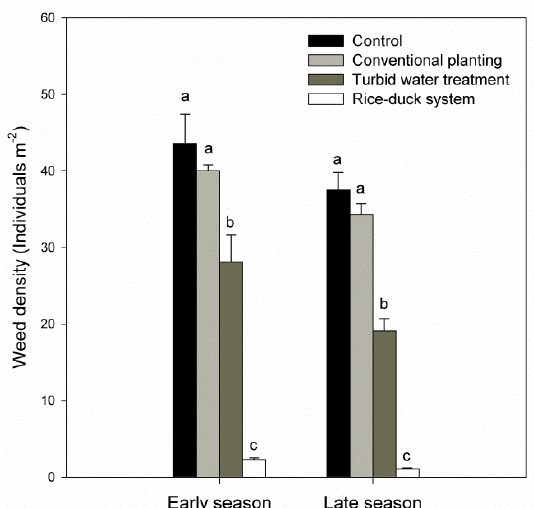
Figure 5. Weed density in the early and late seasons of rice growth under the treatments and control. Bars present the mean and error bars present the standard error ( n = 3). Different lowercase letters above bars indicate statistically significant differences among treatments in the early or late rice growing season. Significance level was set at p < 0.05.